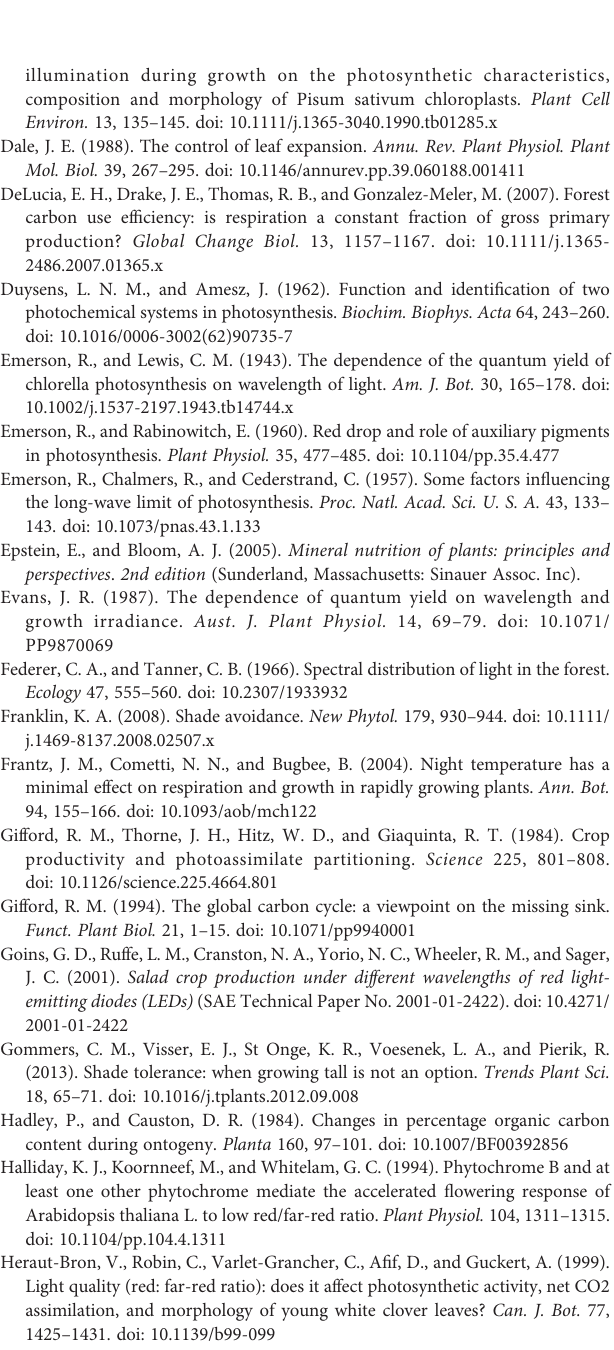
density in m mol m − 2 s − 1 . Plants were seeded in a greenhouse and moved into a multi- chamber gas exchange system two days after seedling emergence (indicated by Day 0 on the x-axis). Downward pointing arrows indicate when far-red LEDs were turned off. SUPPLEMENTARY FIGURE 2 | Relationships between estimated phytochrome photoequilibria (PPE) and leaf area of lettuce grown with or without far-red photons under two background light spectra — white and red/blue (RB). The decrease in the estimated PPE under each background light was due to a 15% far-red substitution. All four spectral treatments had equal total photon fl ux of 350 m mol m − 2 s − 1 (400 to 750 nm) and 31.5% blue